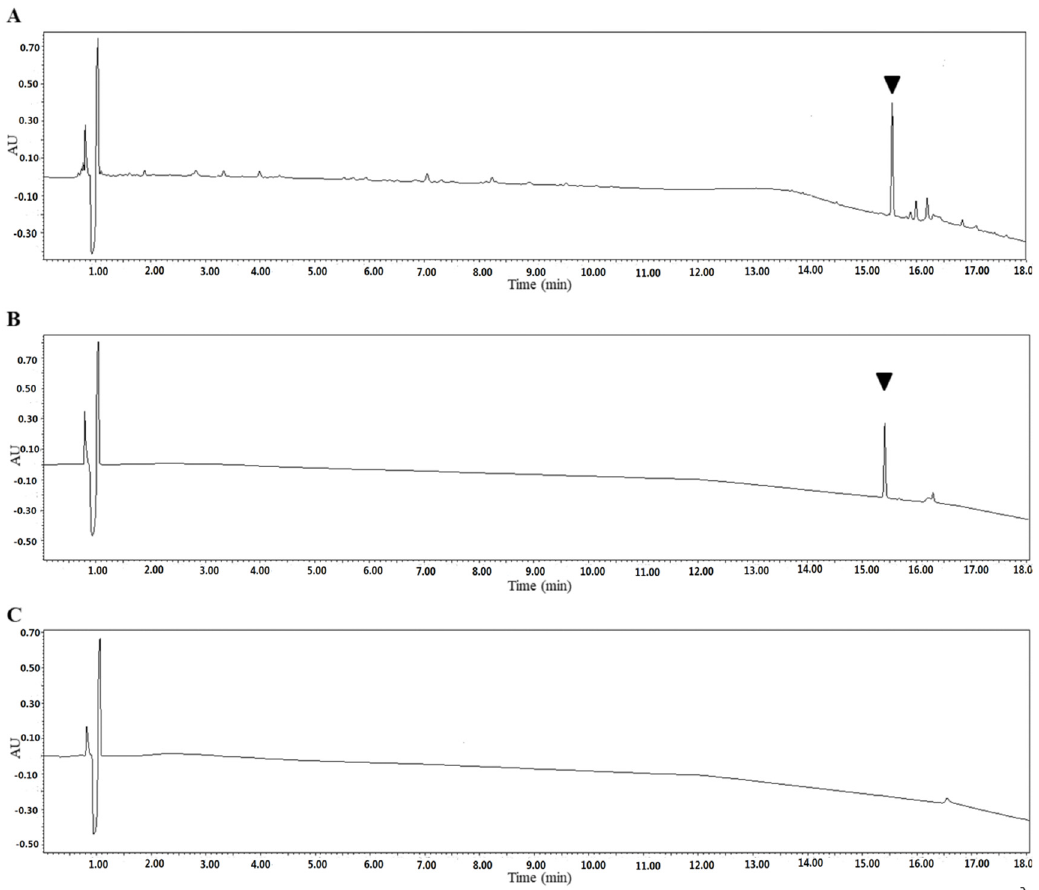
Figure 6. Identification of the SSE by UPLC. UV light absorption spectrum of the SSE at the wavelength of 210 nm. ( A ) UPLC profile of the SSE. ( B ) UPLC profile of the major compound after purification. ( C ) UPLC profile of the control without the SSE. The arrow indicated the major compound.